Question: What does this figure show? Answer in one sentence.
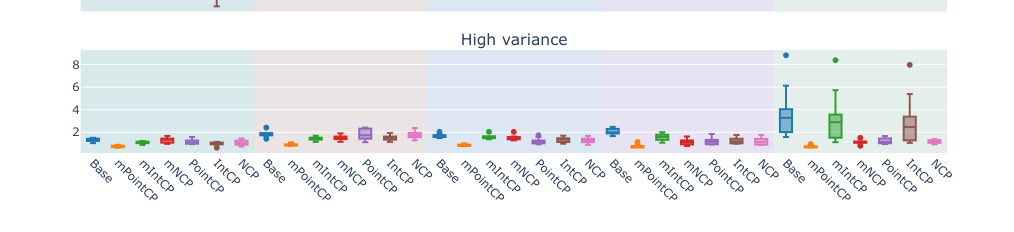
Answer: 3: Division of the feature space X = [0, 1]2 based on two differ- ent taxonomy functions. The first one simply thresholds the second dimen- sion (at 𝜉= 0.2), whereas the second one performs equal-frequency bin- ning on the (conditional) standard deviation, which has the form shown in Eq. (4.16).